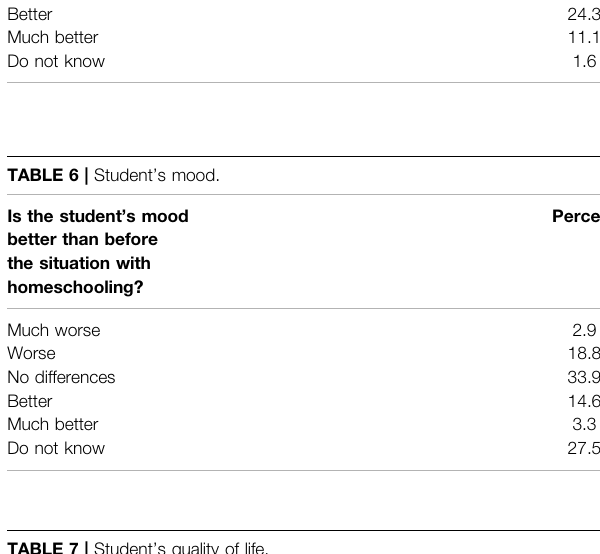
TABLE 7 | Student ’ s quality of